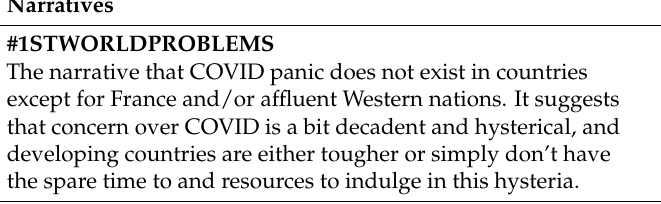
Table 1. Narratives (in English and in